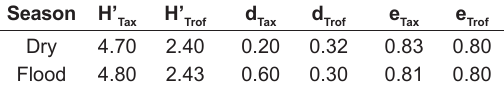
Table 4. Taxonomic diversity index (H’ ), taxonomic Tax dominance index (d ), Pielou’s taxonomic evenness Tax index (e ), trophic diversity index (H’ ), trophic Tax Trof dominance index (d ) and Pielou’s trophic evenness Trof index (e ) for the six sampled stretches of the Urucu Trof River during the dry and flood seasons.